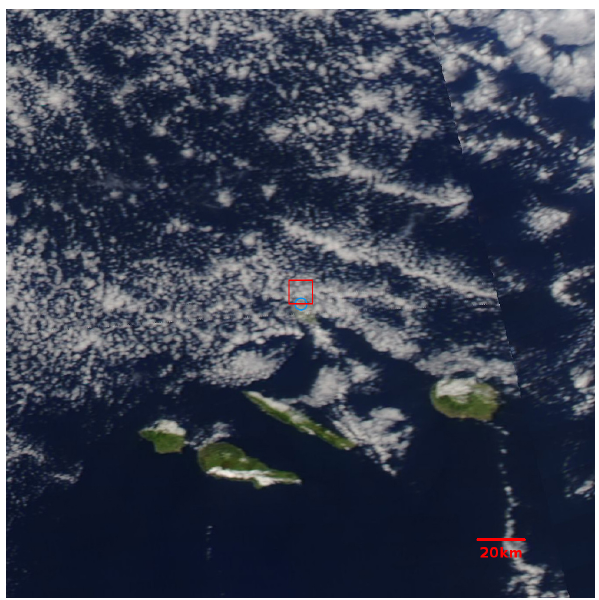
Figure 1. Satellite True Color image (250 × 250km) taken on 8 July 2017 at 15:45UTC (i.e., during flight no. 5; the time given corresponds to the left swath covering most of the image) by the MODIS instrument on Aqua overpassing Azores, centered on Gra- ciosa airport (blue circle), with the overlaid helicopter operation area (red box). The image was acquired from NASA Worldview Snapshots.